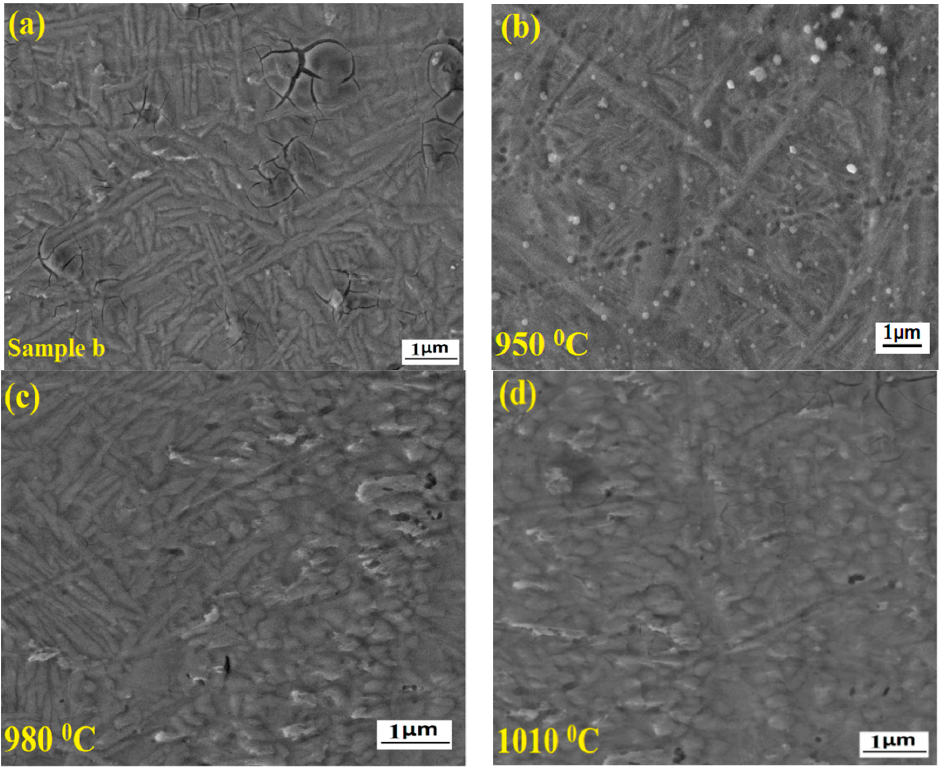
Figure 11. Microstructure of weld joints under different annealing conditions. ( a ) Sample b; ( b ) at 950 °C; ( c ) at 980 °C; ( d ) at 1010 °C.